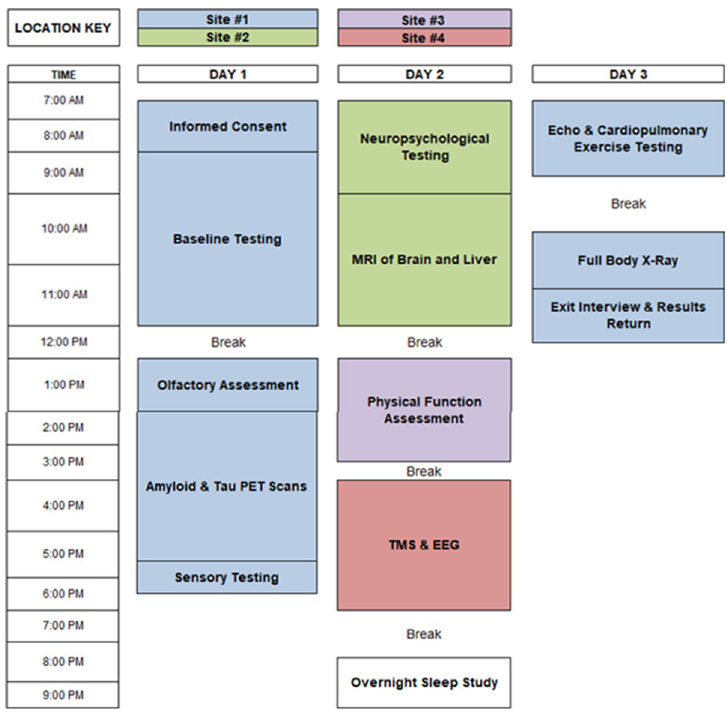
Fig 2. Daily participant testing protocol for the Football Players Health Study’s In-Person